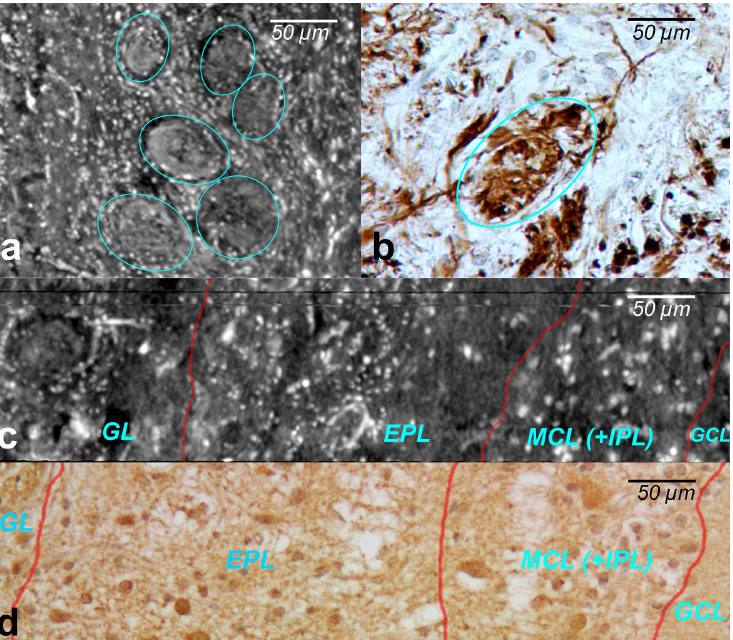
Figure 3. ( a ) XPCT image of the OB soft tissue (coronal section)—the glomeruli layer of the olfactory bulb. The glomeruli are the spherical structures outlined with blue lines: ( b ) immunohistochemical image of the OB soft tissue with a glomerular corresponding to ( a ); ( c ) XPCT image of the OB (sagittal section), and ( d ) immunohistochemical image corresponding to ( c ). From left to right: (GL) glomeruli in the glomerular layer, (EPL) tufted cells in the external plexiform layer, and (ML) mitral cells in the mitral cell